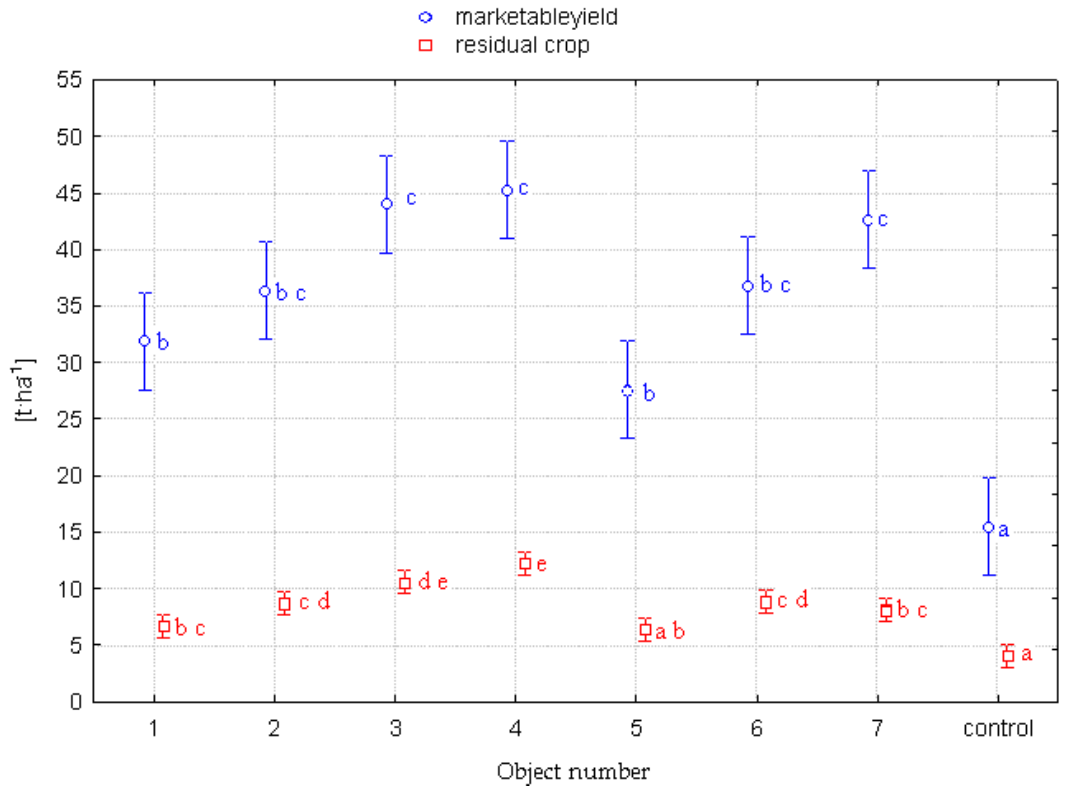
Figure 1. Amount of marketable and residual crop.